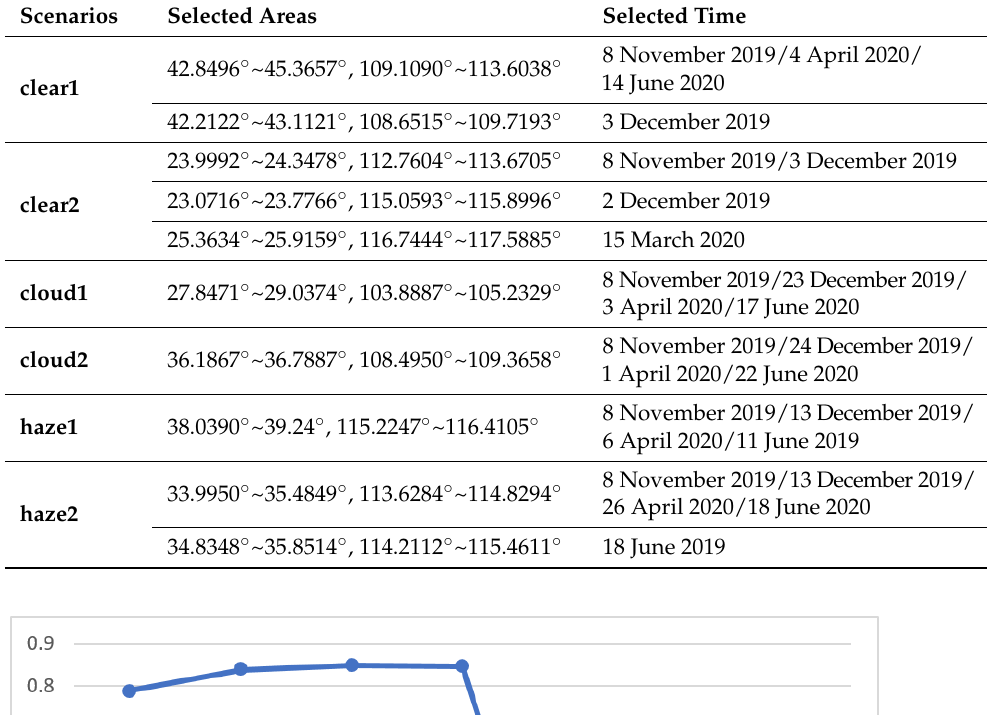
Table 3. The MERSI-II data set used for training the identification condition with bright surfaces.